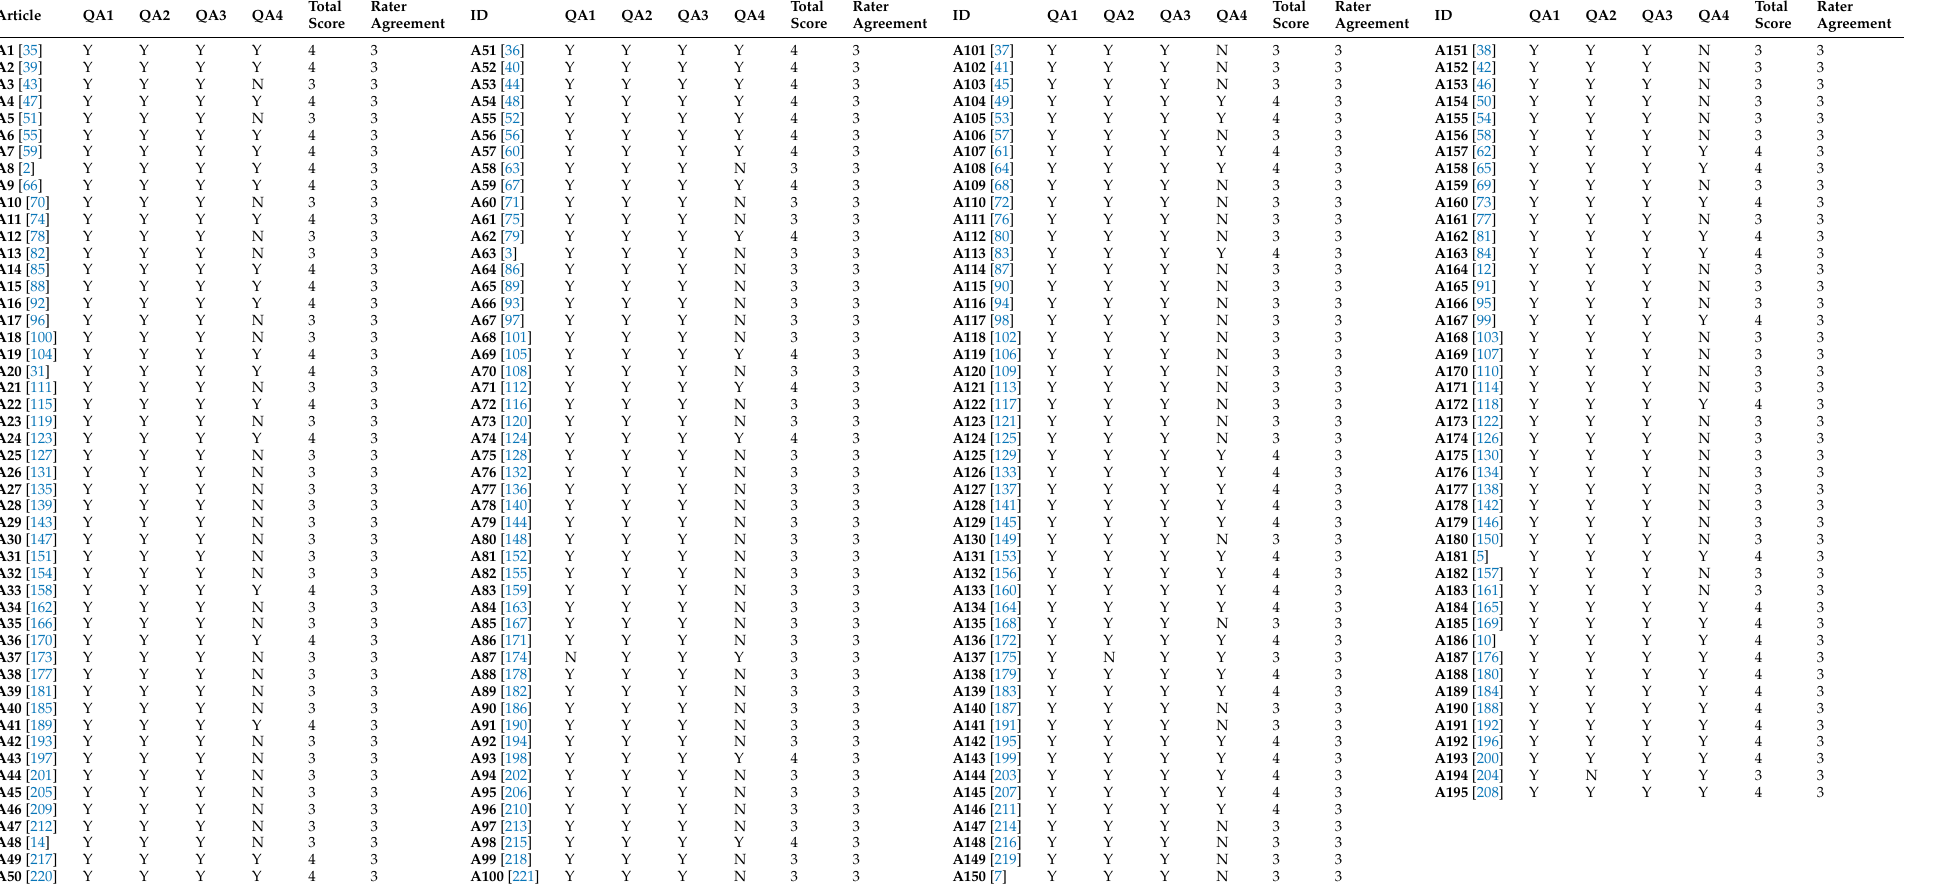
Table 2. Quality evaluation of